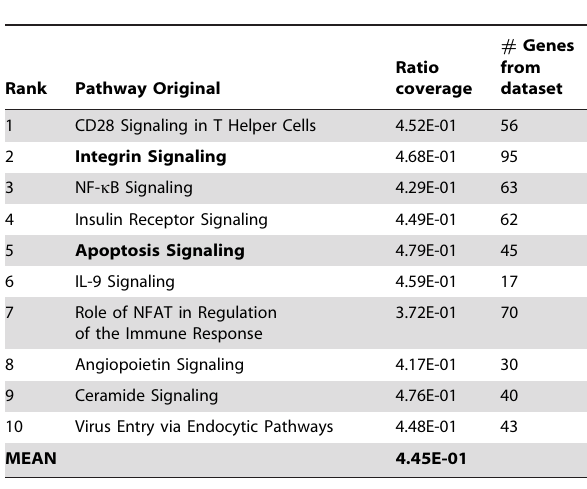
Top 10 of significant pathways identified by Ingenuity Pathway Analysis for the re-annotated whole microarray dataset. Pathways in bold were found in the top 10 series of both the original and re-annotated datasets. Ratio Coverage = the number of genes from the data set that map to the pathway divided by the total number of genes that map to the canonical pathway is displayed (Ingenuity H